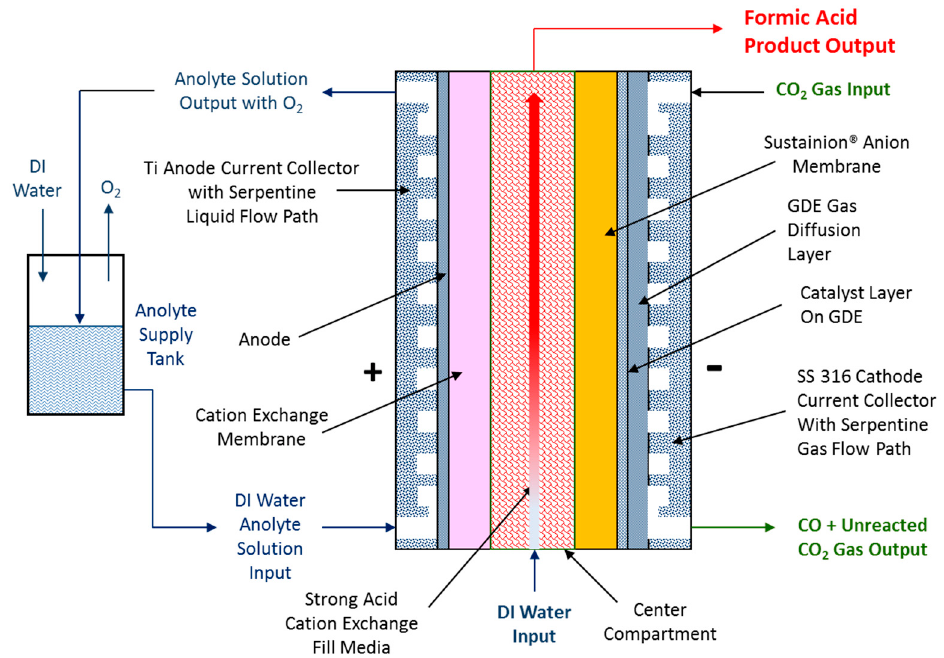
Figure 1. Electrochemical formic acid (FA) cell system configuration in converting CO 2 to a pure FA product [11,13,14]. The center compartment incorporates a strong acid cation ion exchange media that provides a higher ionic conductivity than the lower ionic conductivity FA solution product.